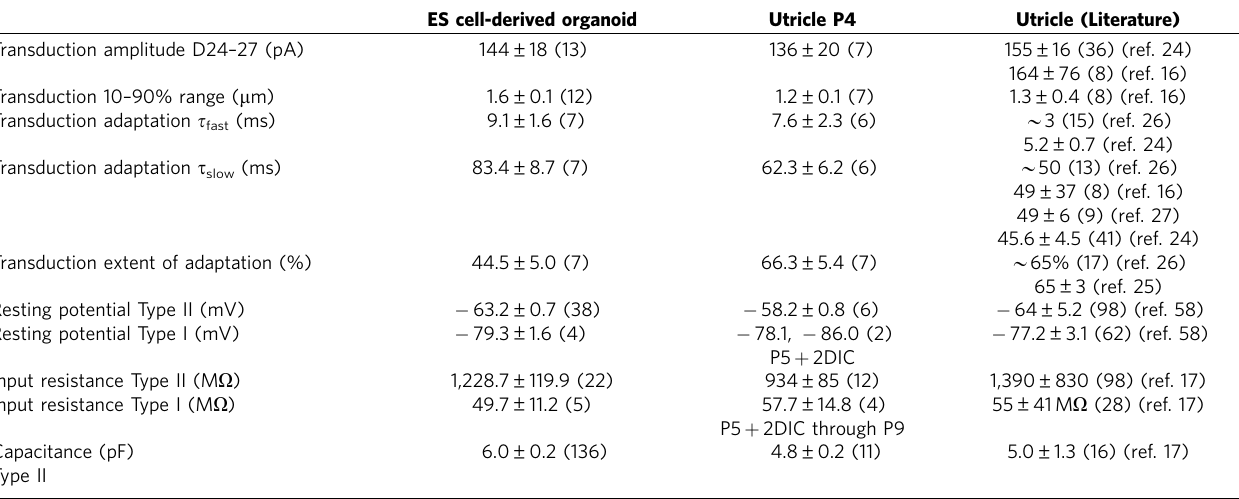
Table 1 | Properties of mechanotransduction and general electrophysiology in hair cells from organoids, utricles and values from the